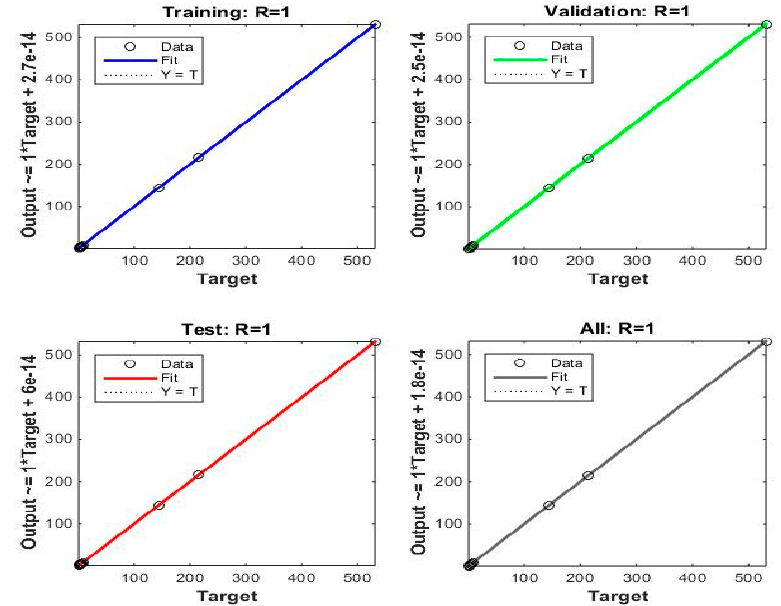
Figure 5. Linear regression for ANN training, validation, testing, and combined input datasets.